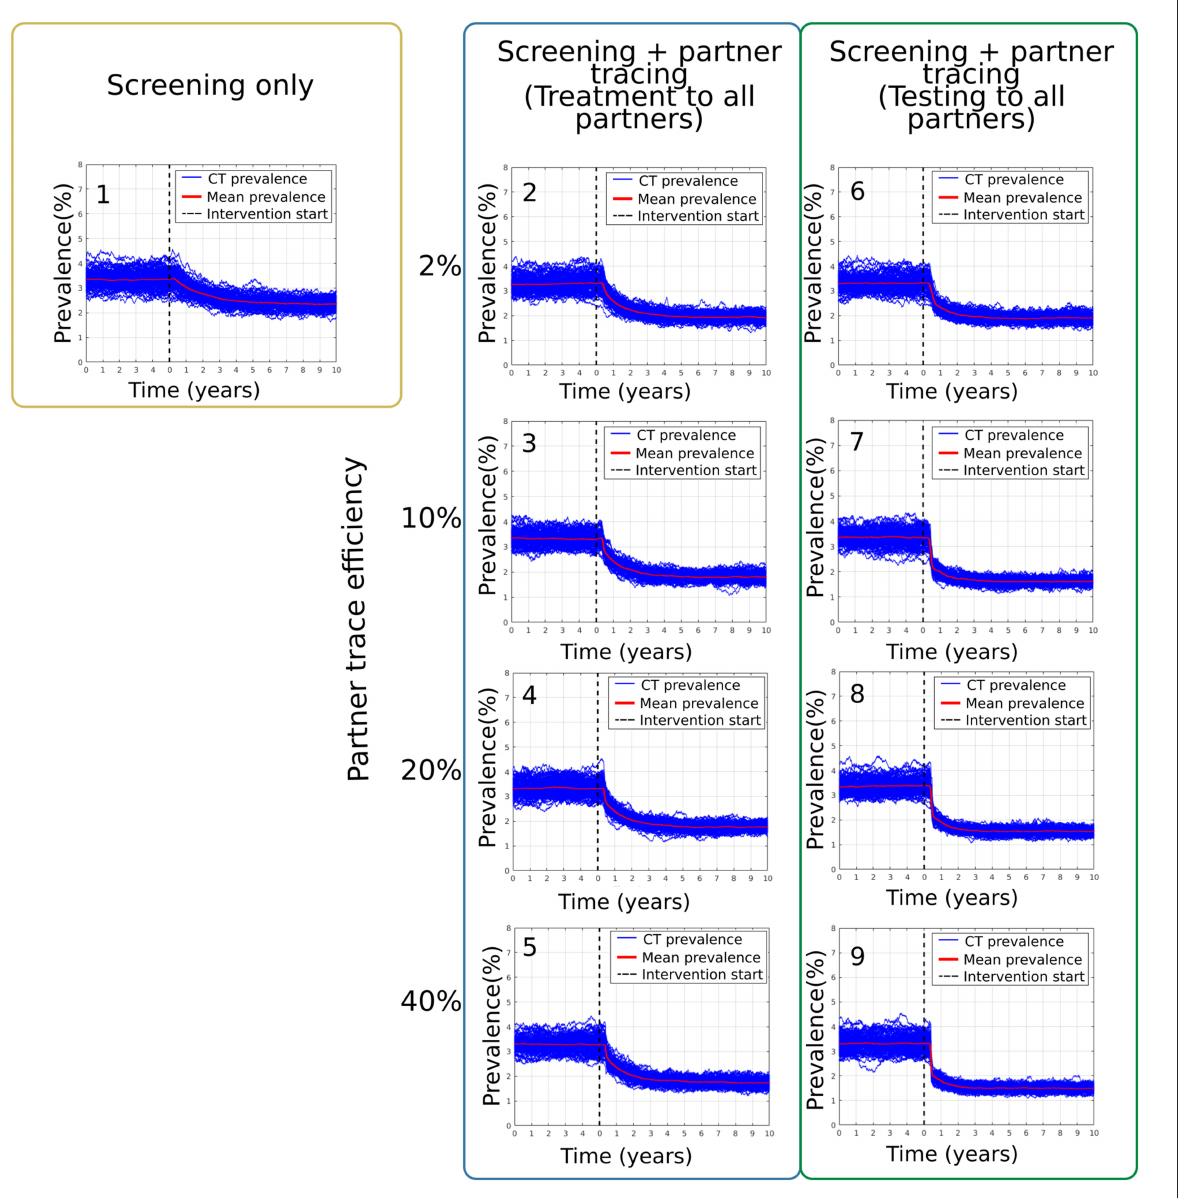
FIGURE3 Results from the scenarios targeting the high-risk population as defined by the number of partners. Section (1) corresponds to scenario Di. Sections (2–5) present the prevalence results from scenarios Dii-Dv and (6–9) are from scenarios Ei-Eiv.